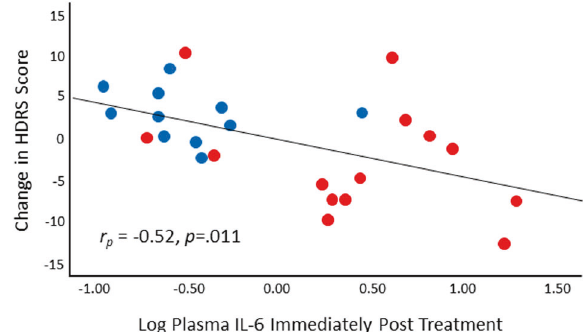
Fig. 5 Partial regression plot illustrating the relationship between residuals of the natural log transformed plasma concentrations of interleukin (IL)-6 and residualized change in Hamilton Depression Rating Scale (HDRS) score. The Pearson correlation between the two sets of residuals is equal to the partial correlation between HDRS scores at week 2 post-WBH/sham treatment and the natural log transformed concentration of plasma IL-6 assessed immediately post-WBH/sham treatment (controlling for baseline HDRS scores and baseline natural log transformed concentration of plasma IL-6, respectively). HDRS Hamilton Depression Rating Scale, IL interleukin, WBH whole-body